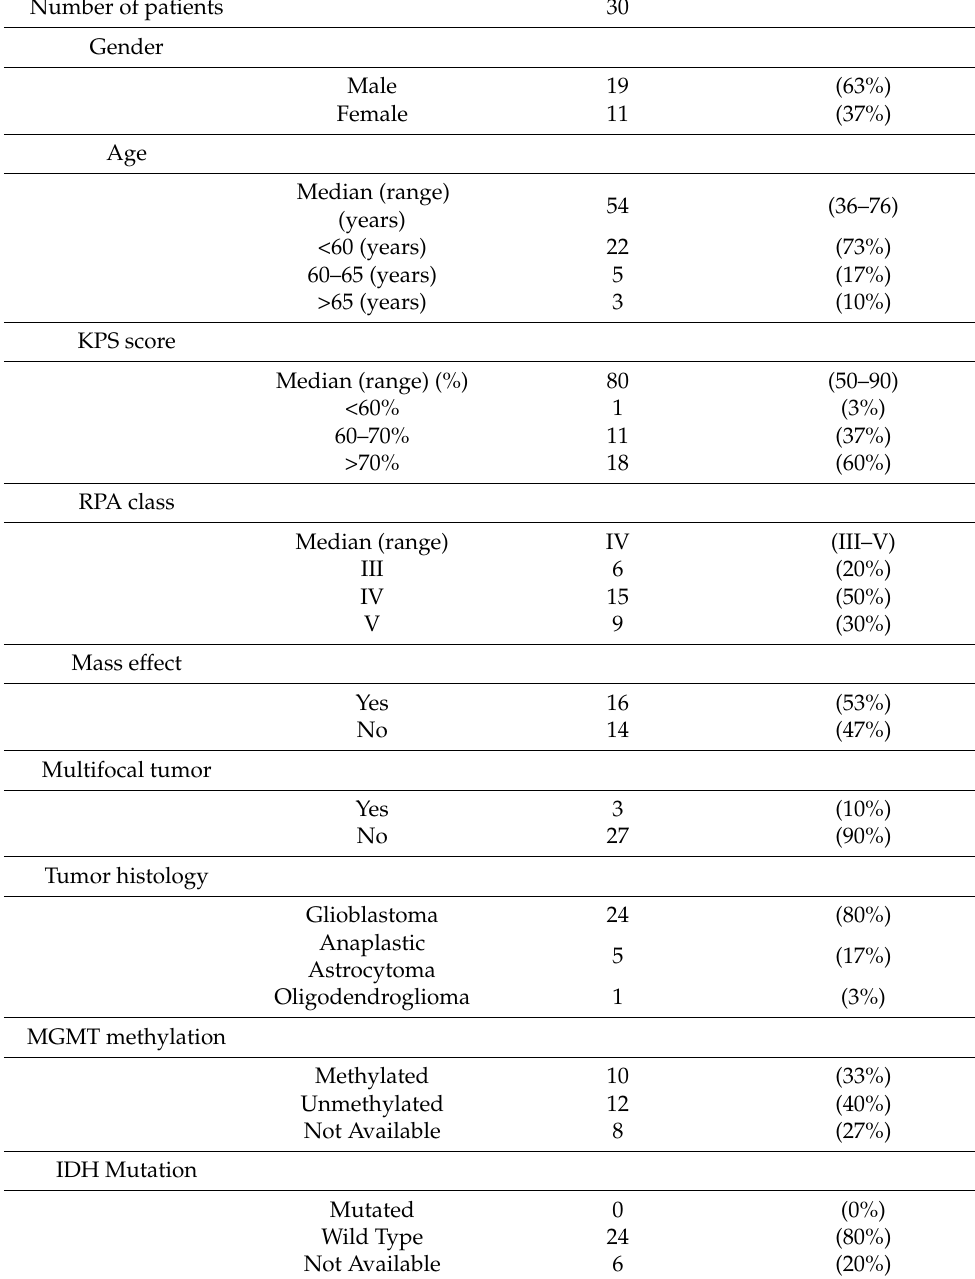
Table 1. Patients and tumor